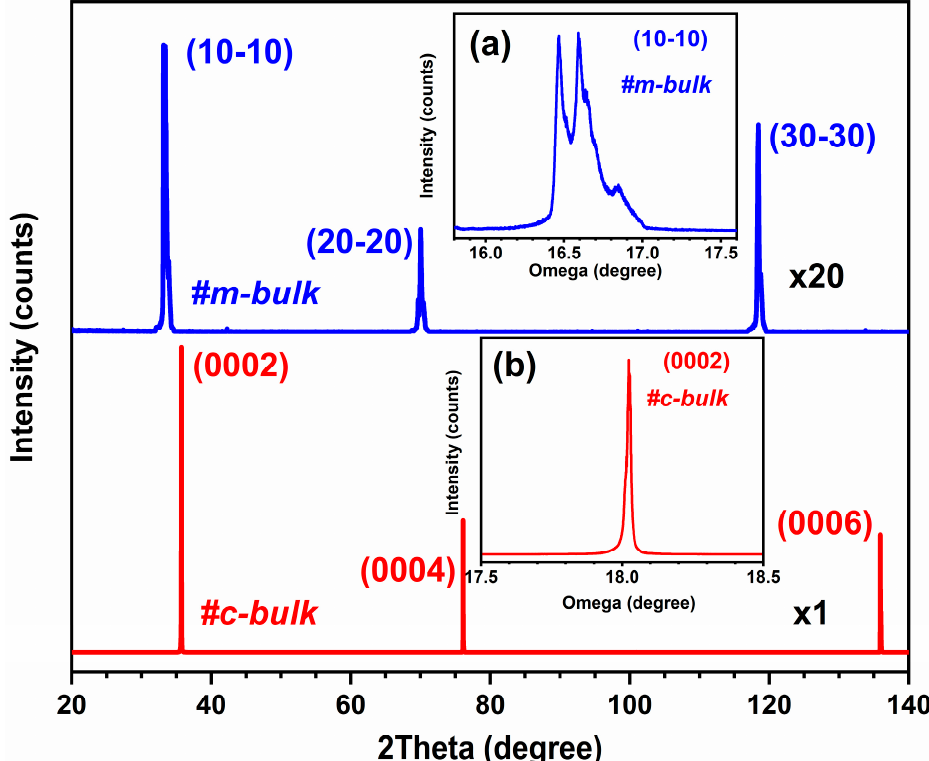
Figure 1. XRD profiles of two bulk AlN crystals, multiplied 20 and 1 times for m-bulk and c-bulk samples, respectively. Inset ( a ) is a rocking curve of (10 − 10) planes with Omega Rel scan mode of the m-bulk sample. Inset ( b ) is a rocking curve of (0002) planes with Omega Rel scan mode of the c-bulk sample.